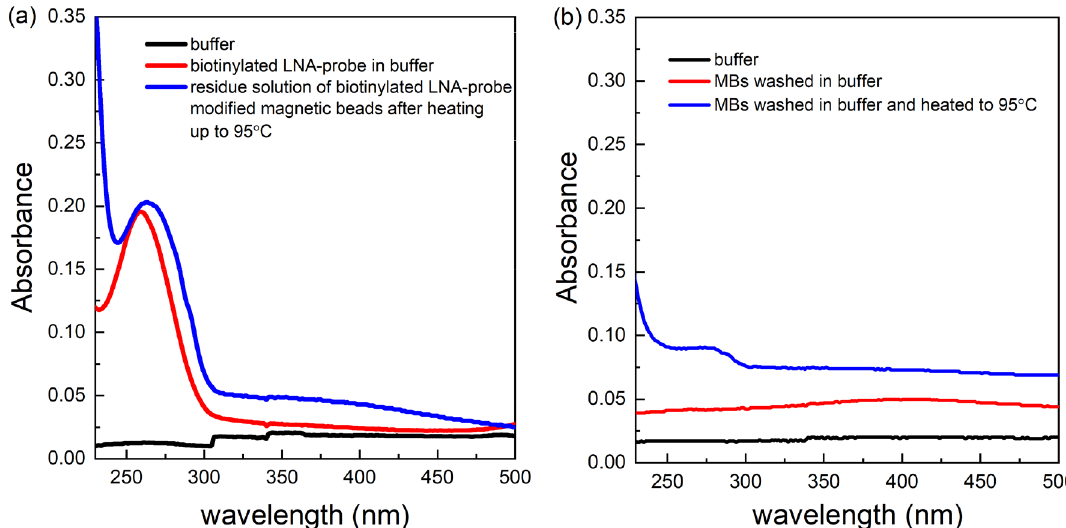
Figure 3. ( a ) A UV absorbance graph for blank buffer (black line), biotinylated LNA probe in buffer (red line), and the residue buffer solution after the heating up of LNA modified magnetic beads at 95 °C for 10 min (blue line). ( b ) UV absorbance graph for blank buffer (black line), residue solution of magnetic beads after being washed in buffer (red line), residue solution of magnetic beads after being washed and heated up at 95 °C for 10 min in buffer (blue line). The absorbance levels below 230 nm were considered as noise due to the increased absorbance of the quarts cuvette itself upon being subjected to light at wavelengths lower than 250